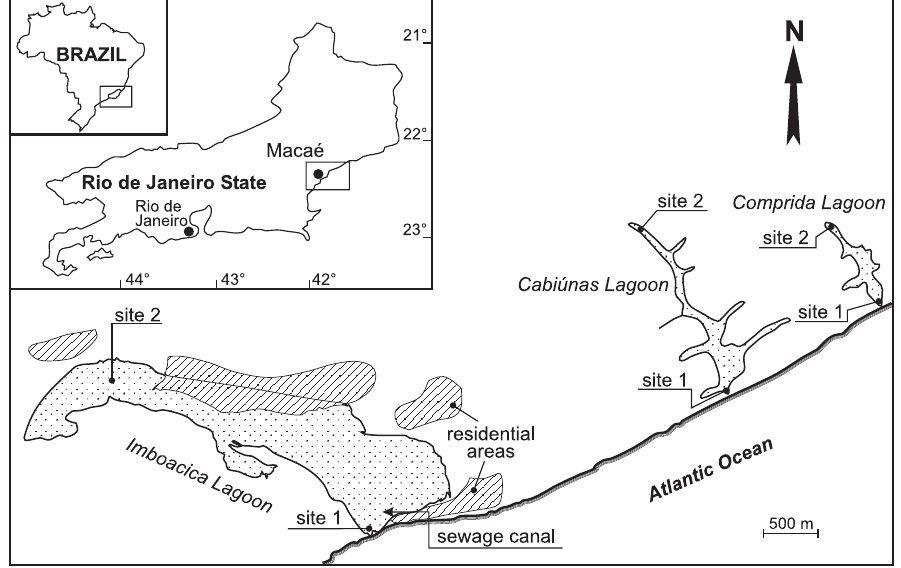
Fig. 1 – Location of study area and indication of sampling sites in three investigated coastal lagoons.